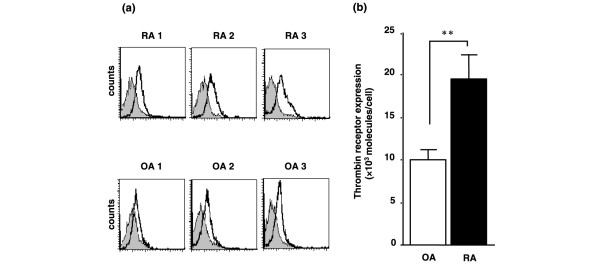
Overexpression of thrombin receptor on SFs from patients with RA. (a) Histograms representing thrombin receptor expression on synovial fibroblasts (SFs) from rheumatoid arthritis (RA) and osteoarthritis (OA) patients. Cells were stained with the antithrombin receptor mAb ATAP2. Flow-cytometric analyses were performed using FACScan. Open histograms represent the number of cells stained with ATAP2 in each logarithmic scale on a fluorescence amplifier. Shaded histograms represent profiles of anti-Thy1.2 mAb as a negative control. (b) Comparison of thrombin receptor expression in RA and OA SFs. The expression of thrombin receptor was analyzed by FACScan. Each value represents the number of molecules expressed per cell, calculated using standard QIFKIT beads from five similar experiments, as described in Materials and methods. Data are expressed as mean ± standard deviation for five independent donors. FACS, fluorescence-activated cell sorter. **P < 0.01.